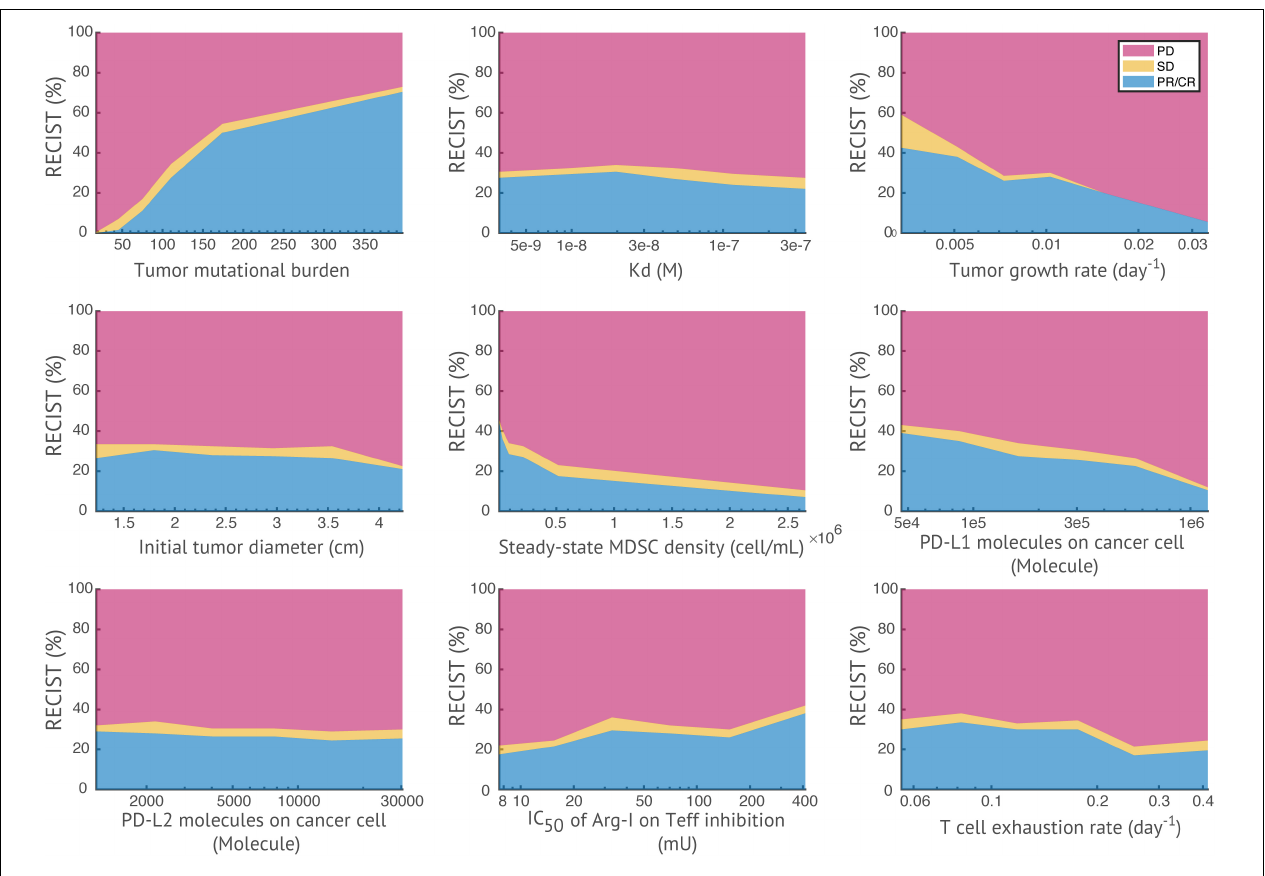
FIGURE 8 | Effects of parameters on patients’ response. For each parameter of interest, virtual patients are sorted by their corresponding parameter values in ascending order, and evenly divided into six subgroups. The response status of each subgroup is plotted against the median parameter values in each subgroup. TMB and effective concentration of Arg-I on Teff inhibition show positive correlations with response rate, while tumor growth rate, steady-state MDSC density, and the number of PD-L1 molecules on cancer cell show negative correlations (i.e., with a > 15% increase/decrease of response rates in